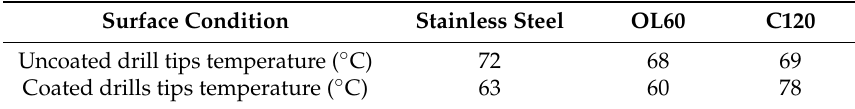
Table 4. Maximum value of temperature at drill tip level, recorded immediately after piercing a 4 mm thick steel